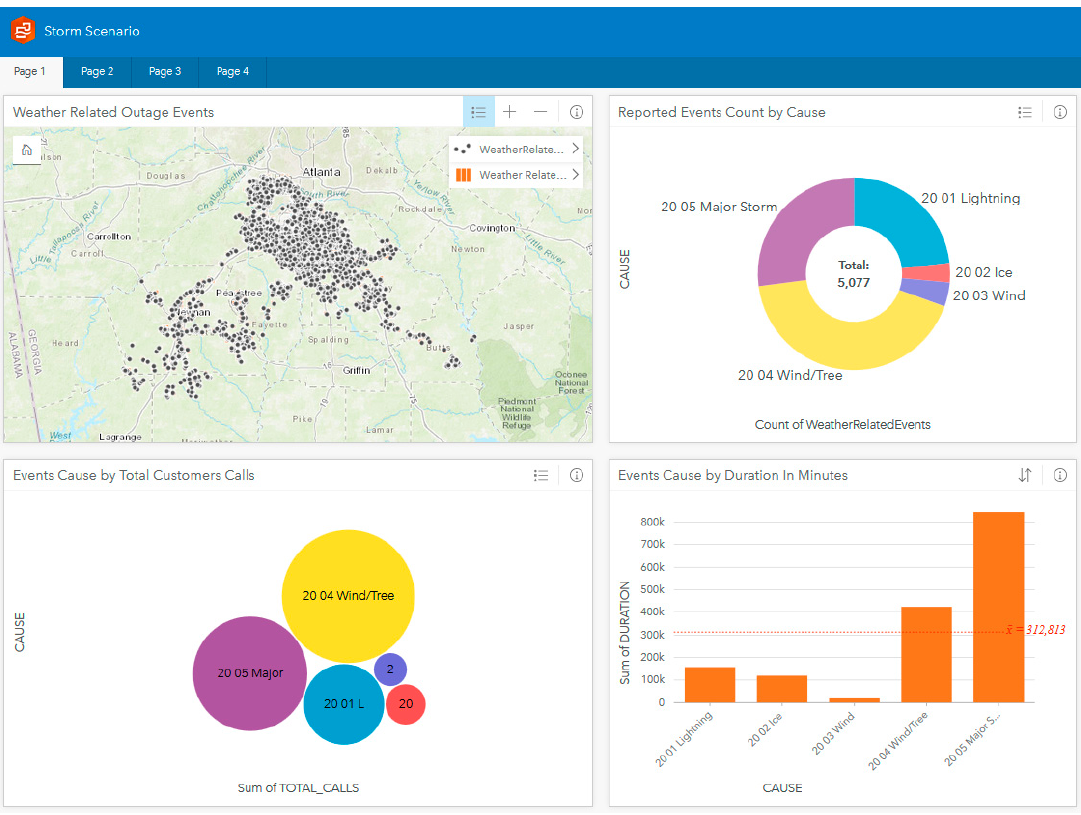
Figure 3. Challenge 1—Storm Scenario Workbook—Page 1.